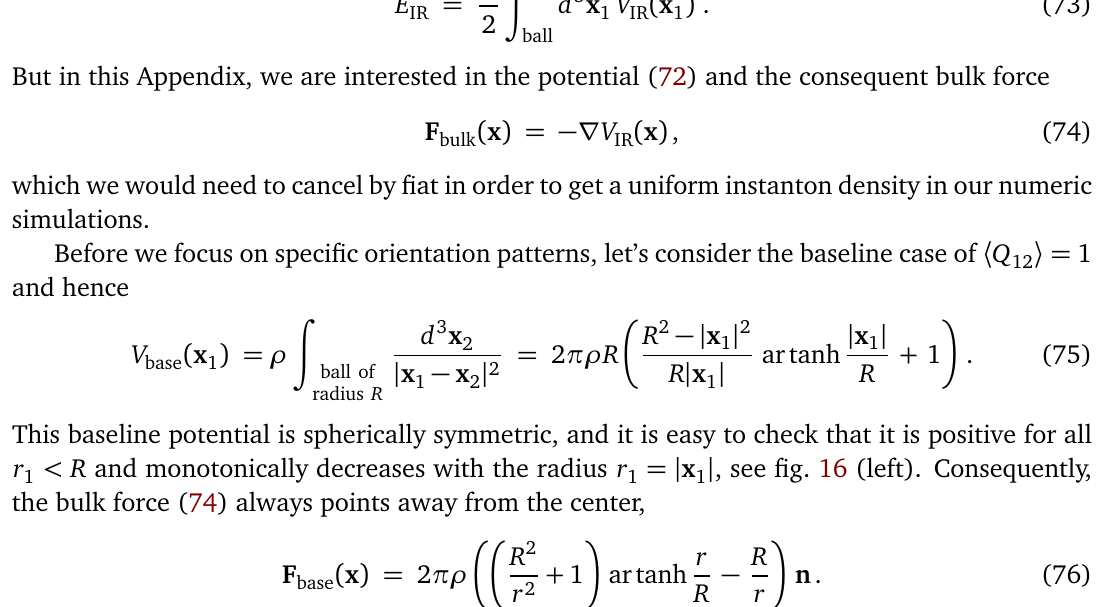
Figure 16: Left: The base potential V | F ( x ) | / 2 πρ R as a function of | x | / R base